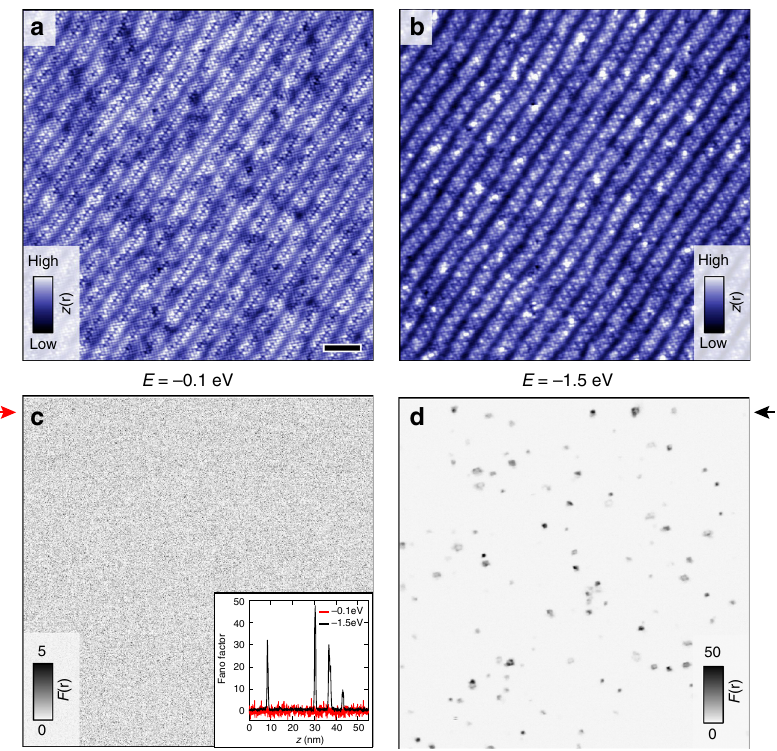
Fig. 1 Noisy defects in Bi2212. a Constant current image, z ( r ), of Bi2212. The scale bar indicates 5 nm, the full fi eld of view is 55 nm ( E = − 100 meV, I = 100 pA). b Constant current image taken directly after ( a ) with E = − 1.5 eV, I = 400pA. c , d Current-noise, or Fano, images ( F ( r )) simultaneously taken with ( a , b ), respectively. The signal-to-noise for ( c ) is set to be able to resolve changes in the slope of a factor of ~5. This can be greatly improved upon by longer averaging or point spectroscopy, see ref. 16 . The inset in ( c ) shows a horizontal line cut through ( c , red trace) and ( d , black trace) at the position indicated by the arrows. Note: the bright spots in ( b ) do not correspond to the locations with excess current-noise in ( d ), see also Supplementary Note